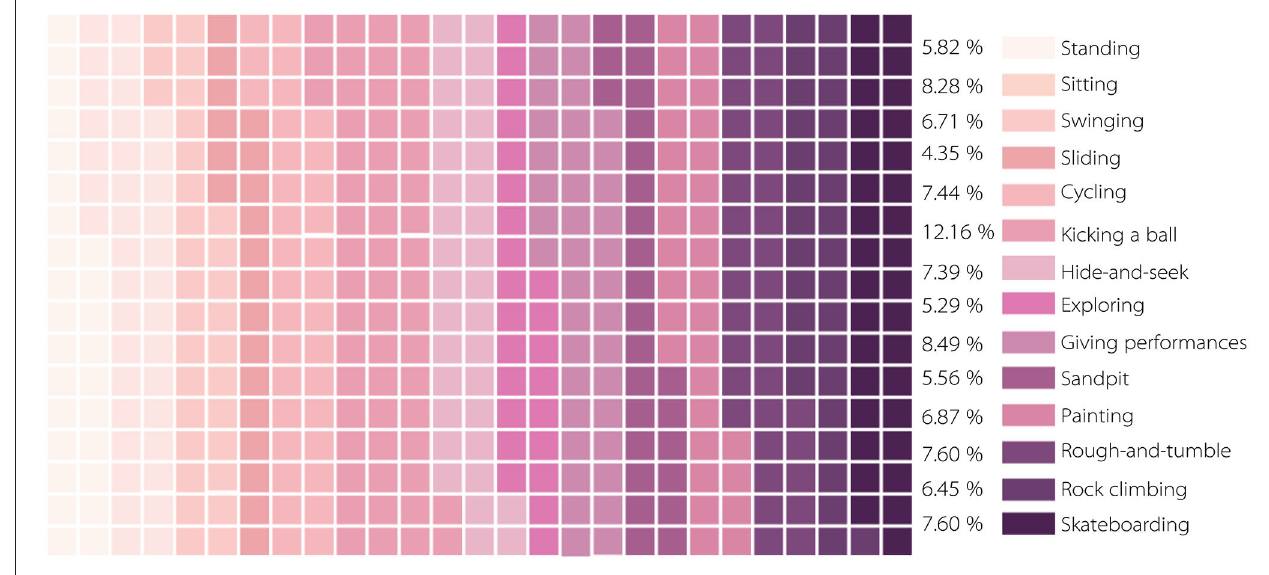
FIGURE 2 | Proportion of physical activity types in children.